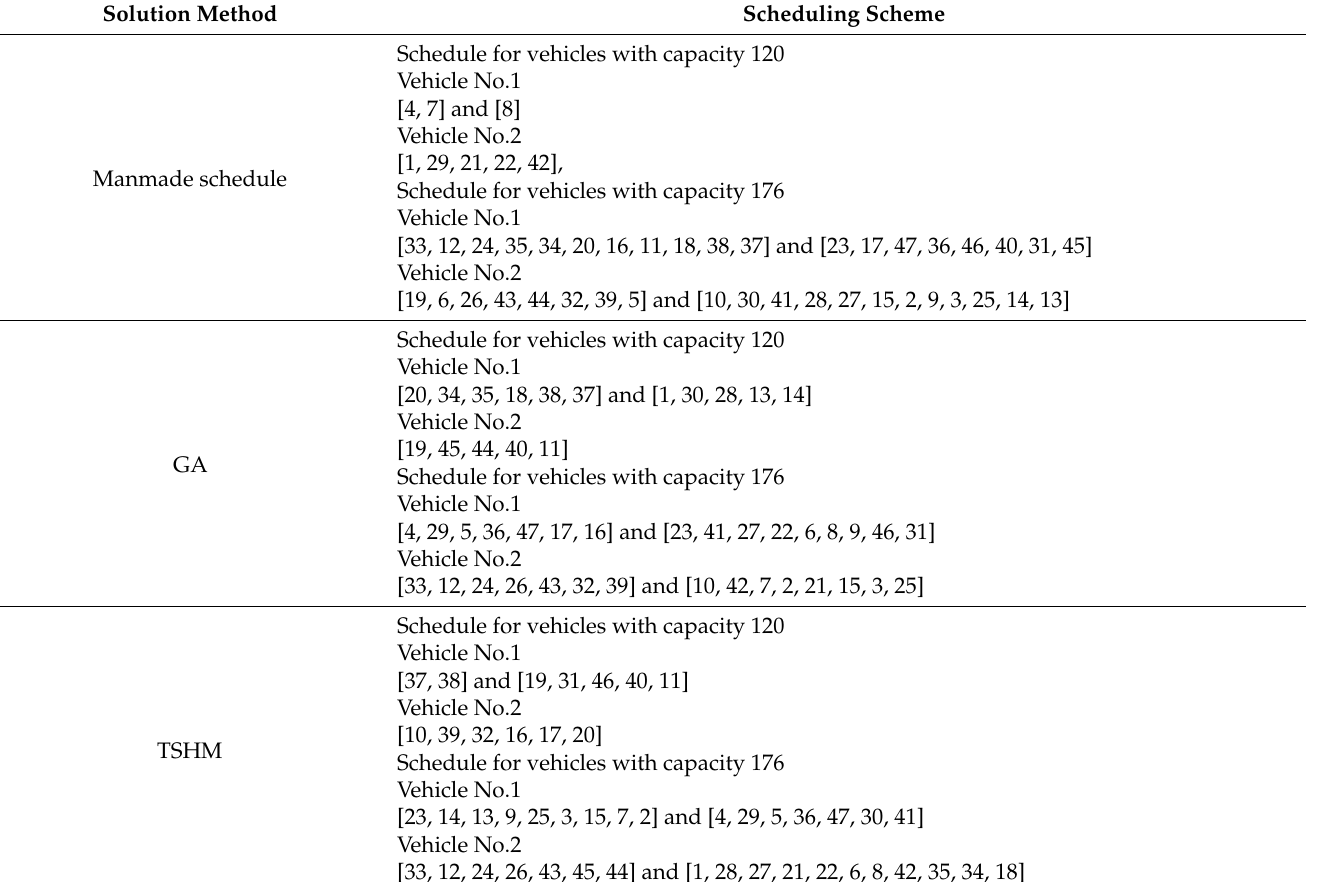
Table 3. Vehicle routes obtained by three methods.